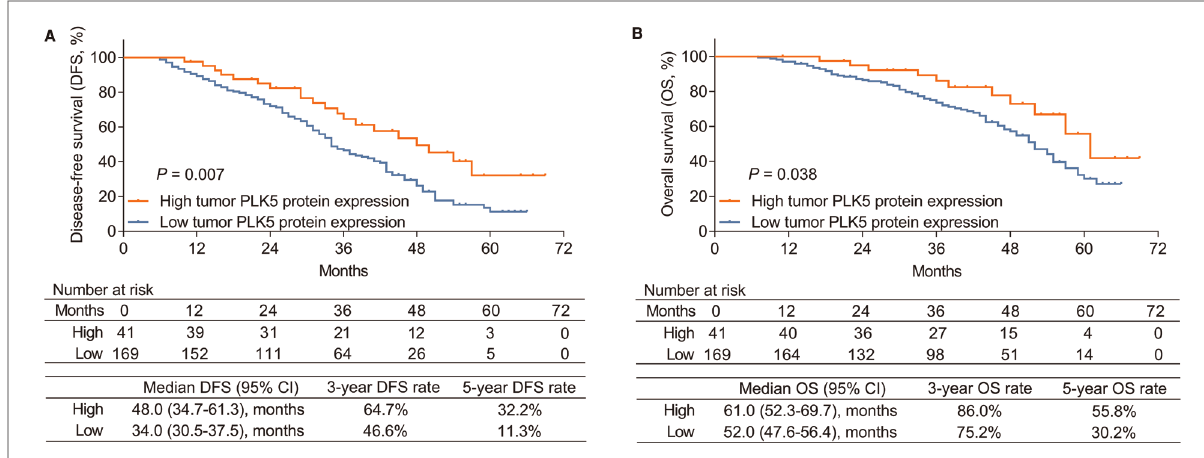
FIGURE 2 Relationship between PLK5 protein expression and survival pro fi le in NSCLC patients. Linkage of PLK5 protein expression with DFS ( A ) and OS ( B ) in NSCLC